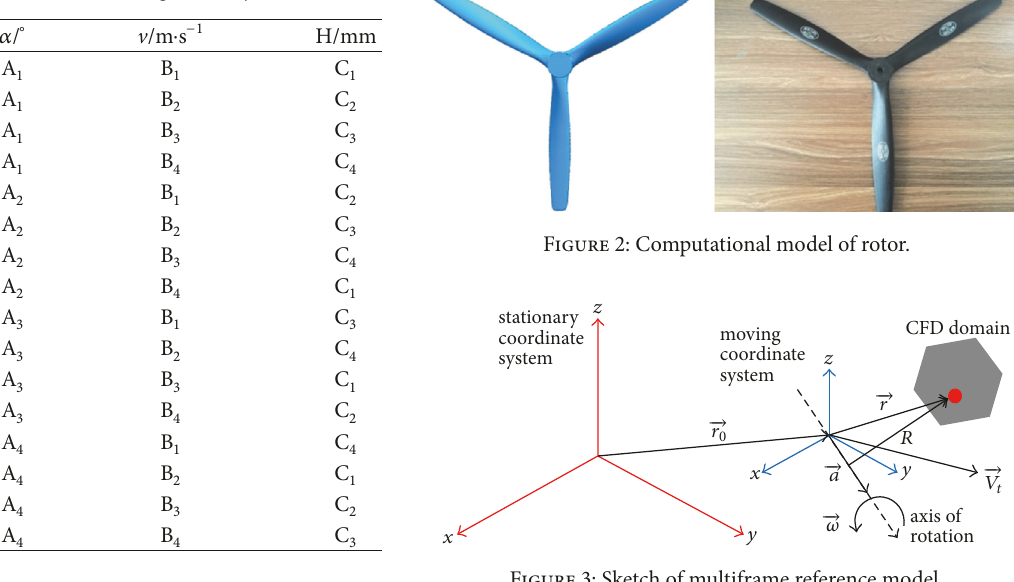
Table 2: Test number of forward flight aerodynamics.